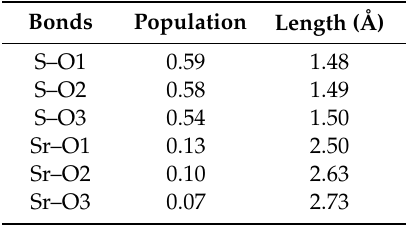
Table 2. Mulliken bond population of celestite.